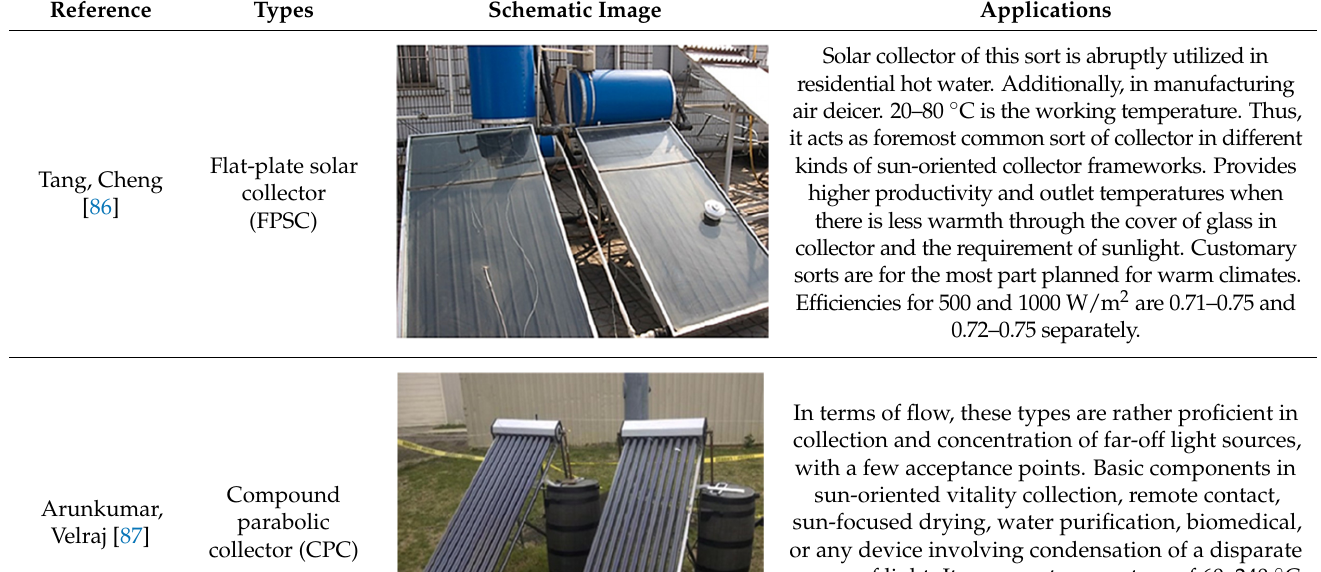
Table 1. Application of hybrid nanofluids in various solar